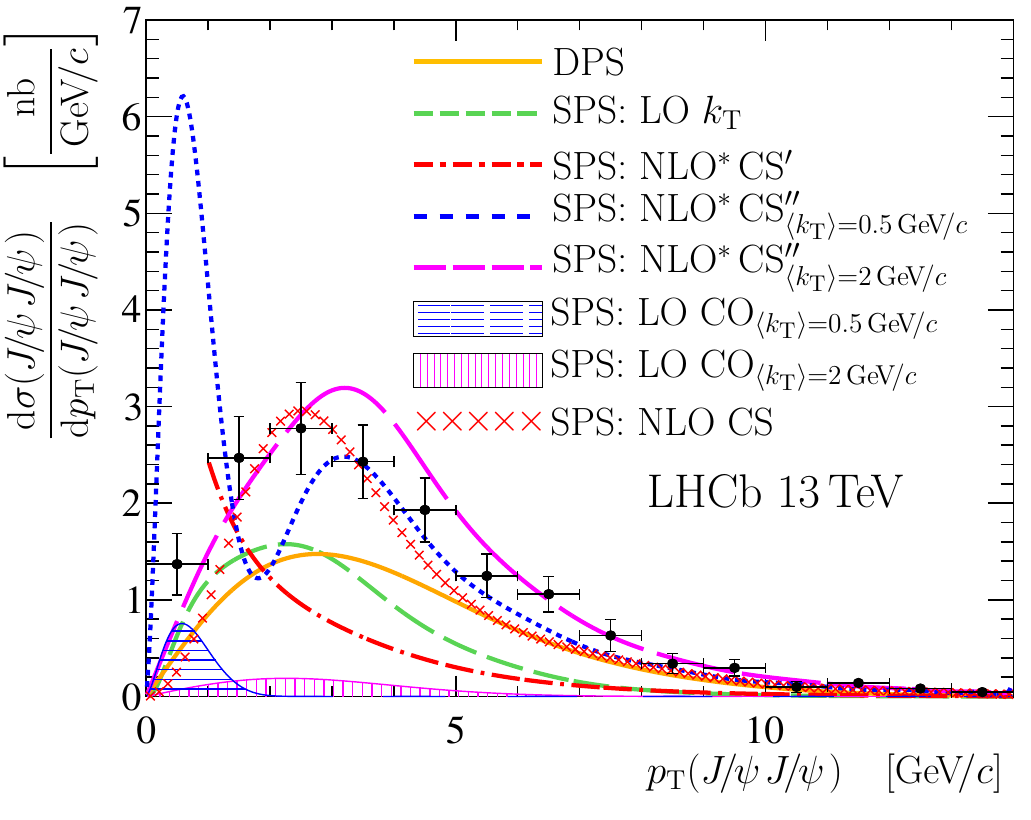
Figure 2 . Comparisons between measurements and theoretical predictions for the di(cid:11)erential cross-sections as a function of p T ( J= J= ). The (black) points with error bars represent the mea-